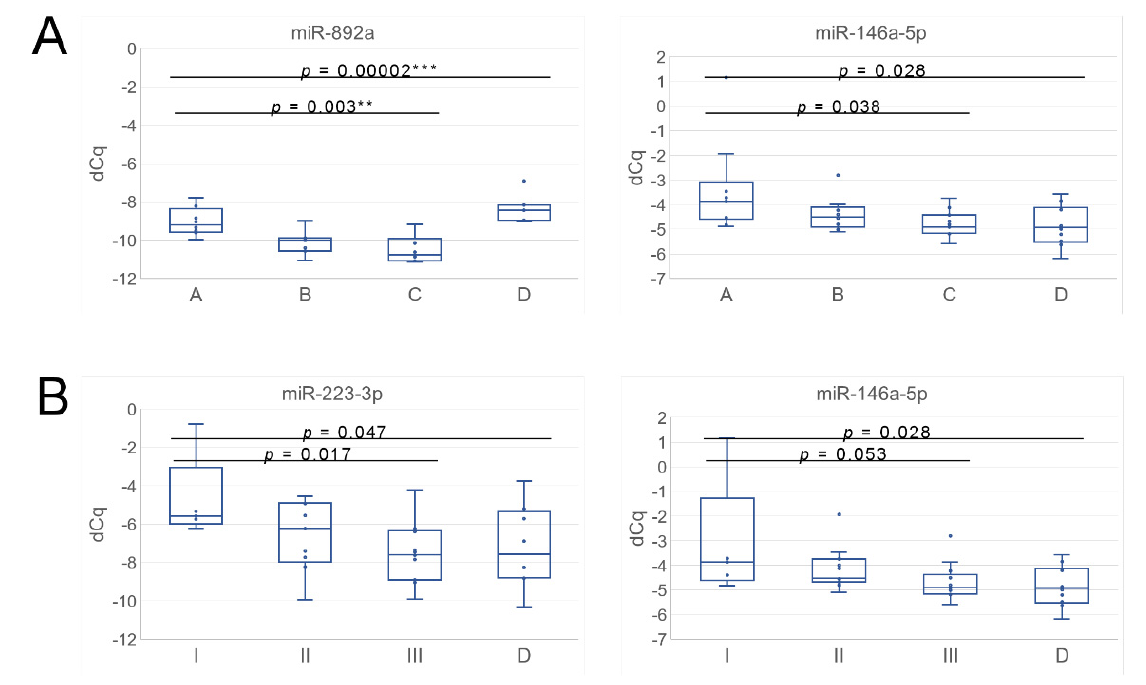
Figure 5. Confirmation of differentially expressed miRNAs by qPCR. Figure depicts expression of the miRNAs with the most significant changes between ( A ) PCa status groups (A–C) or ( B ) PCa progression groups (I–III). For clarity, only ANOVA p -values are shown with and without the healthy (D) group (for individual comparisons, see Table 2). Box-and-whiskers plots present the first quartile, median and third quartile, minimum and maximum values and outliers that are marked outside the whiskers range. Stars after p -values indicate the false discovery rate (FDR p -value ** < 0.01, *** < 0.001). Delta quantification cycle (dCq).